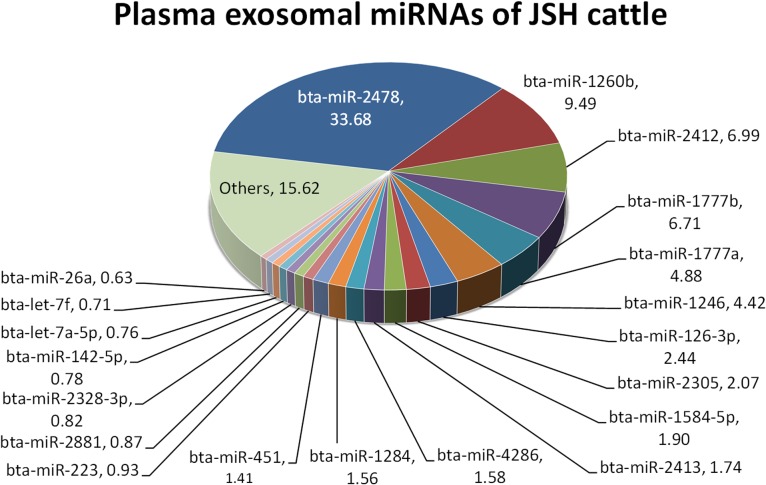
MicroRNA composition of bovine plasma exosome.MicroRNA (miRNA) names and percentages of total miRNA contents are indicated.